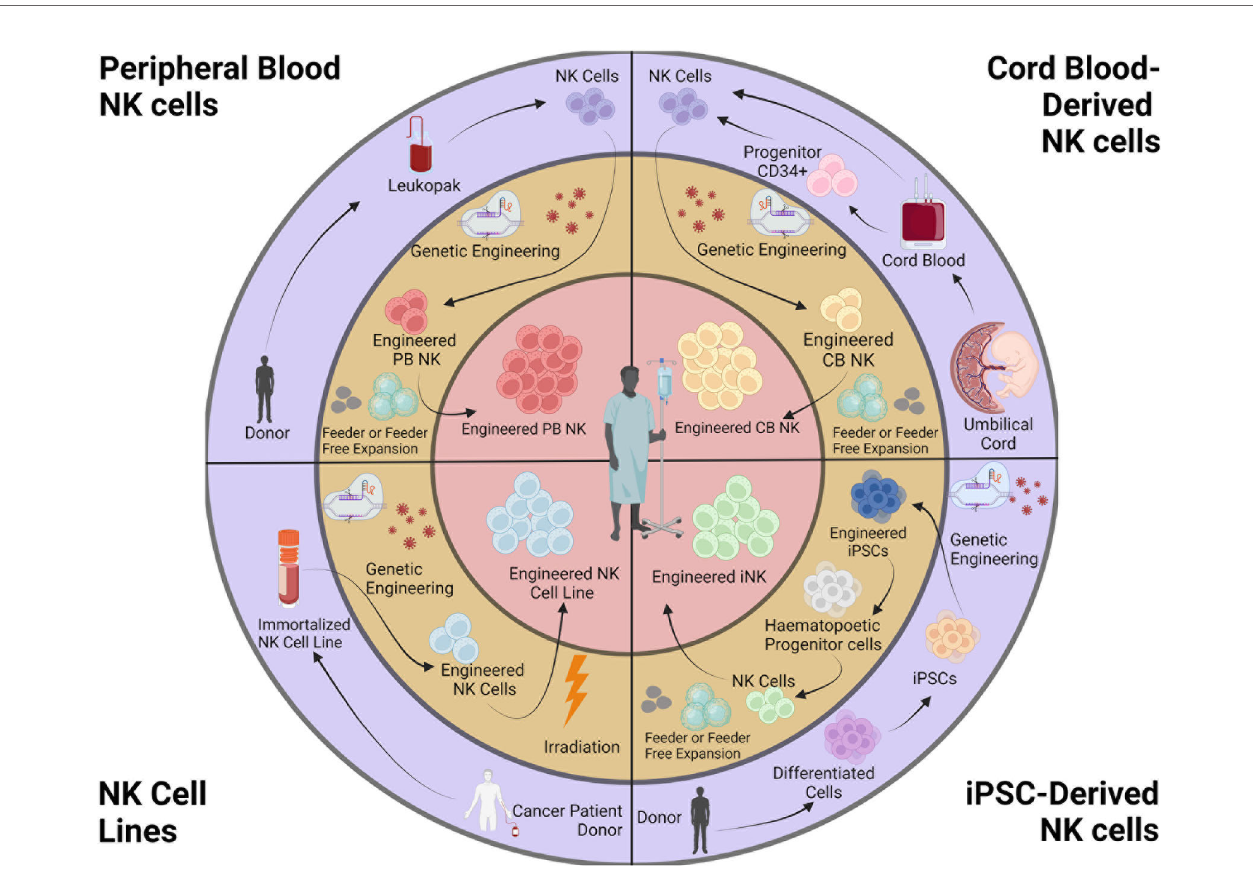
FIGURE 1 | Sources and engineering of NK cell products. NK cells for cancer immunotherapy can be obtained from peripheral blood (autologous or allogeneic), cord blood, iPSCs, and NK cell lines. Isolated NK cells are genetically engineered and expanded. NK cell lines are irradiated before infusion. This fi gure was created using